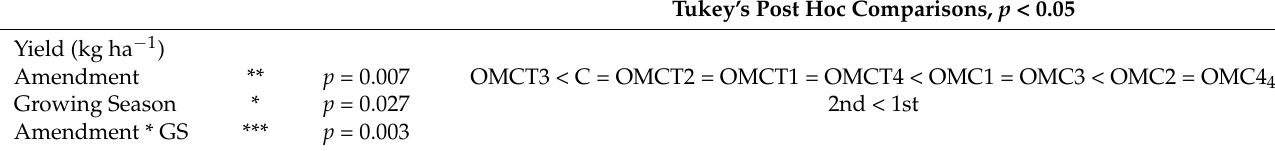
Table 1. Repeated measures ANOVA results for